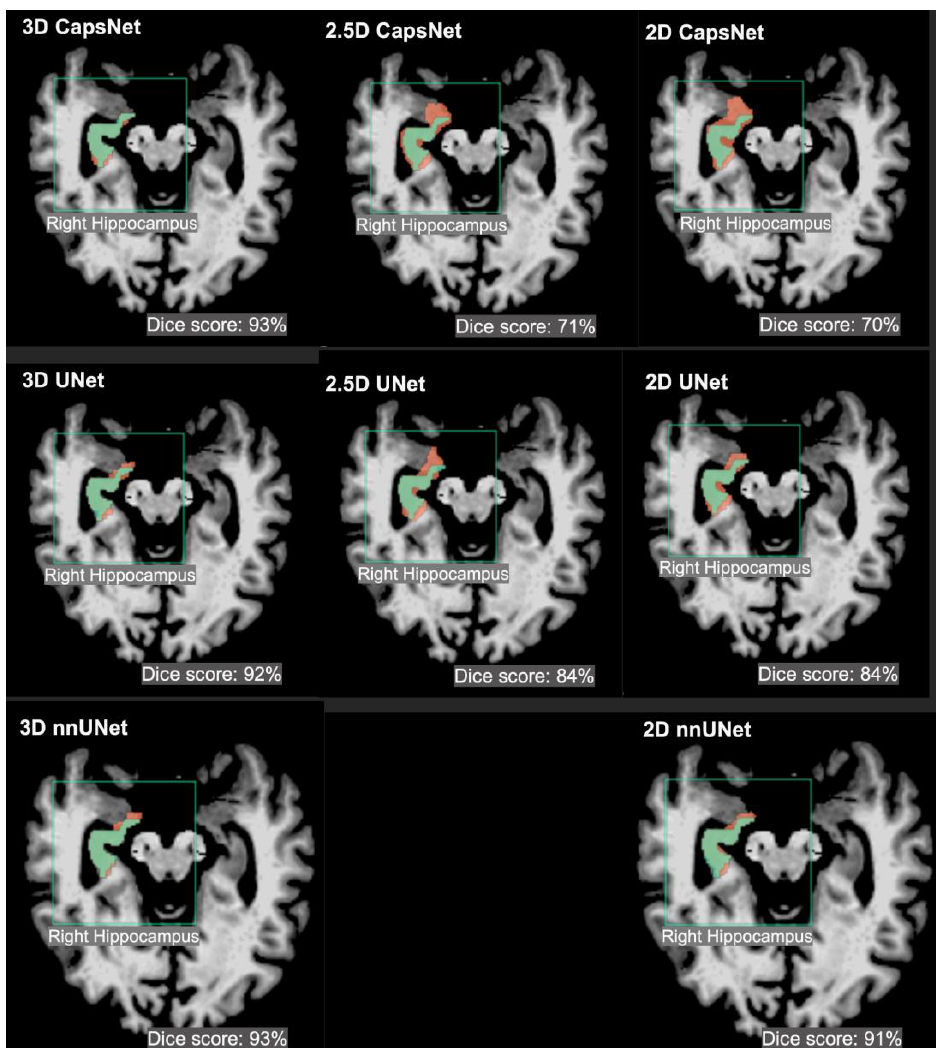
Figure 2. Examples of 3D, 2.5D, and 2D segmentations of the right hippocampus by CapsNet, UNet, and nnUNet. Target segmentations and model predictions are respectively shown in green and red. Dice scores are provided for the entire volume of the right hippocampus in this patient (who was randomly chosen from the test set).